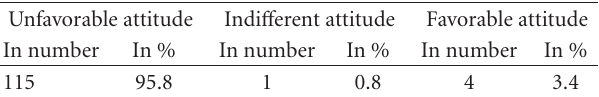
Table 6: Overall attitudes of teachers toward the professional development